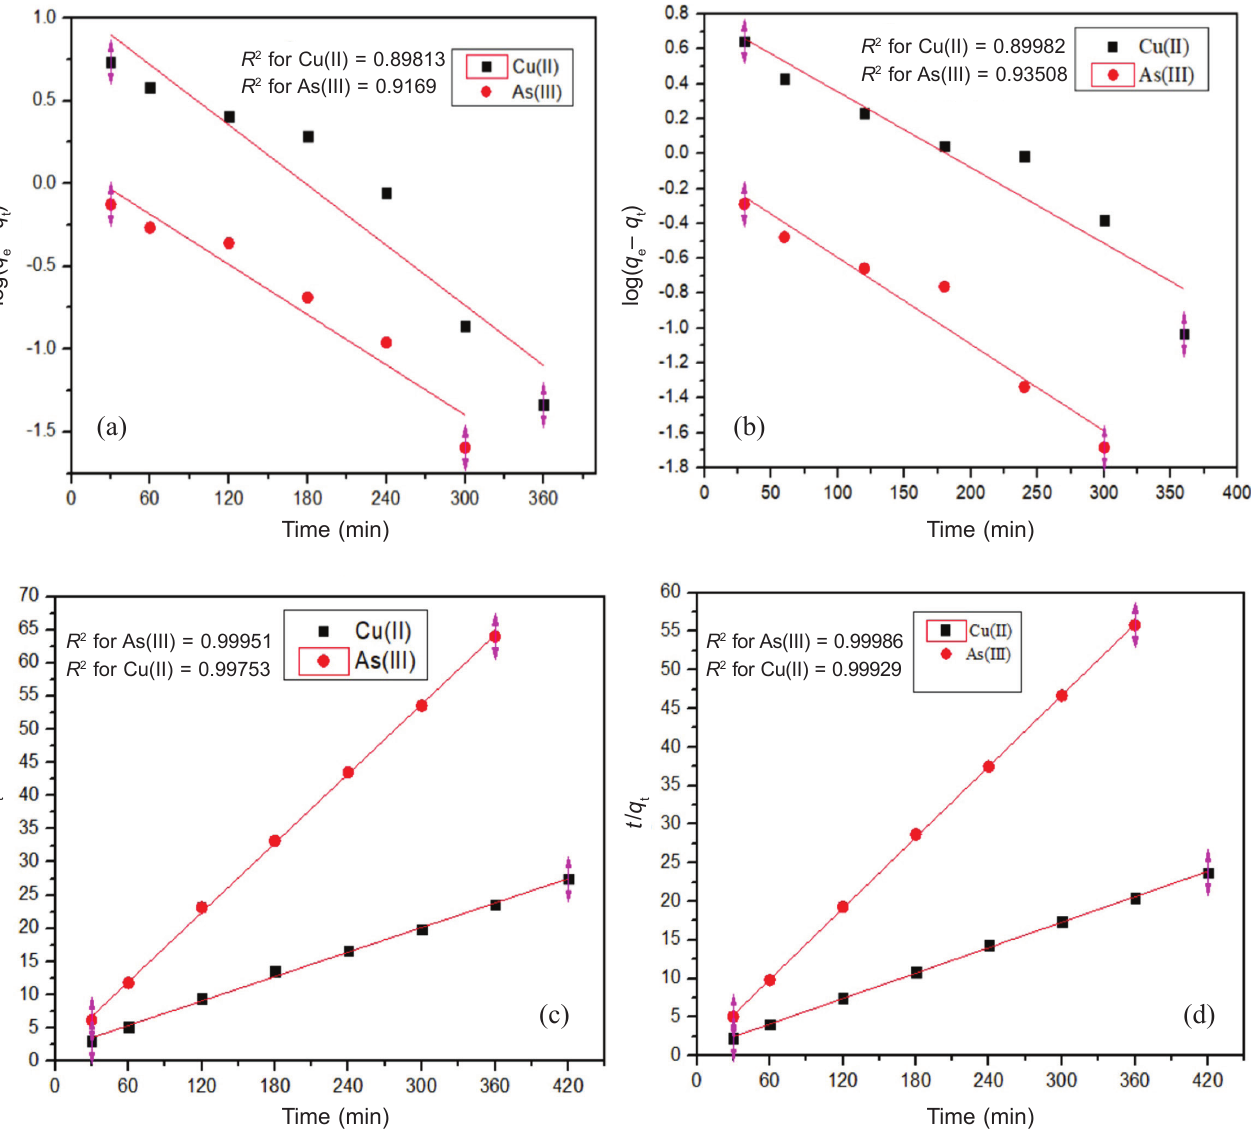
Fig. 11 – Pseudo first-order kinetic model for adsorption of Cu(II) and As(III) on RAC (a), CAMAC (b), and pseudo-second-order kinetic model for adsorption of Cu(II) and As(III) on RAC (c), and CAMAC